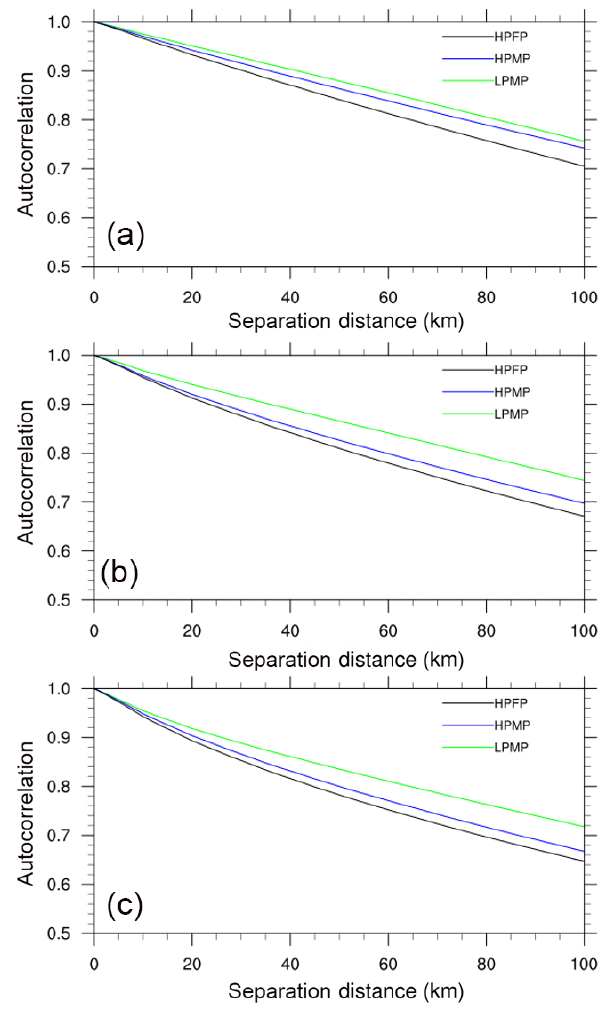
Figure 6. The averaged spatial autocorrelation of brightness tem- perature of the AHI water vapor band (a) 8, (b) 9, and (c) 10 for each precipitation